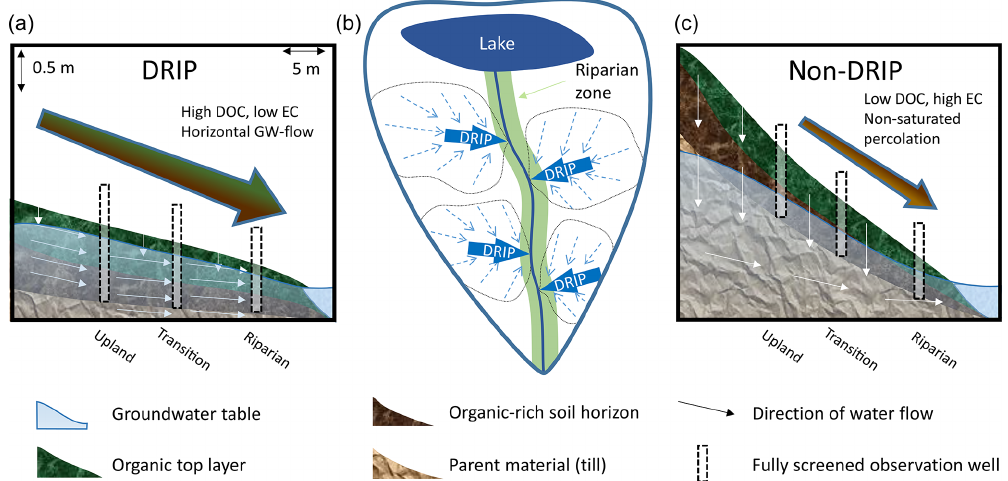
Figure 1. Conceptual illustration of the two types of hypothesized riparian areas along a boreal stream. (b) Discrete riparian inflow points (DRIPs) are focal points in the riparian zone (light green) where pathways converge before reaching the stream. DRIPs typically have flatter topography and higher groundwater tables than non-DRIPs. Panels (a) and (c) show DRIP and non-DRIP riparian zones, respec- tively. Green layers represent the approximate extent of the organic layer, brown layers are riparian soils with high organic matter content, light brown layers represent parent material, transparent blue overlay represents the groundwater table, and black bars represent well transects of DRIP areas in panel (a) and non-DRIP areas in panel (c) . Large arrows suggest the relative hydrological contribution, and the color fill of the arrows matches the soil layer with which the groundwater interacted